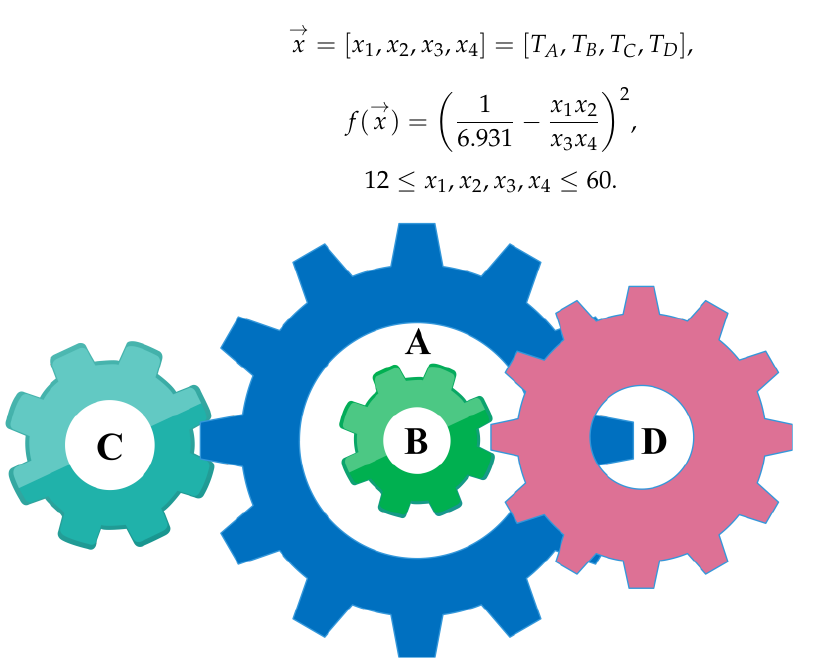
Figure 9. The construction of the gear train design. Here, A B C D represent the serial number of the gear.